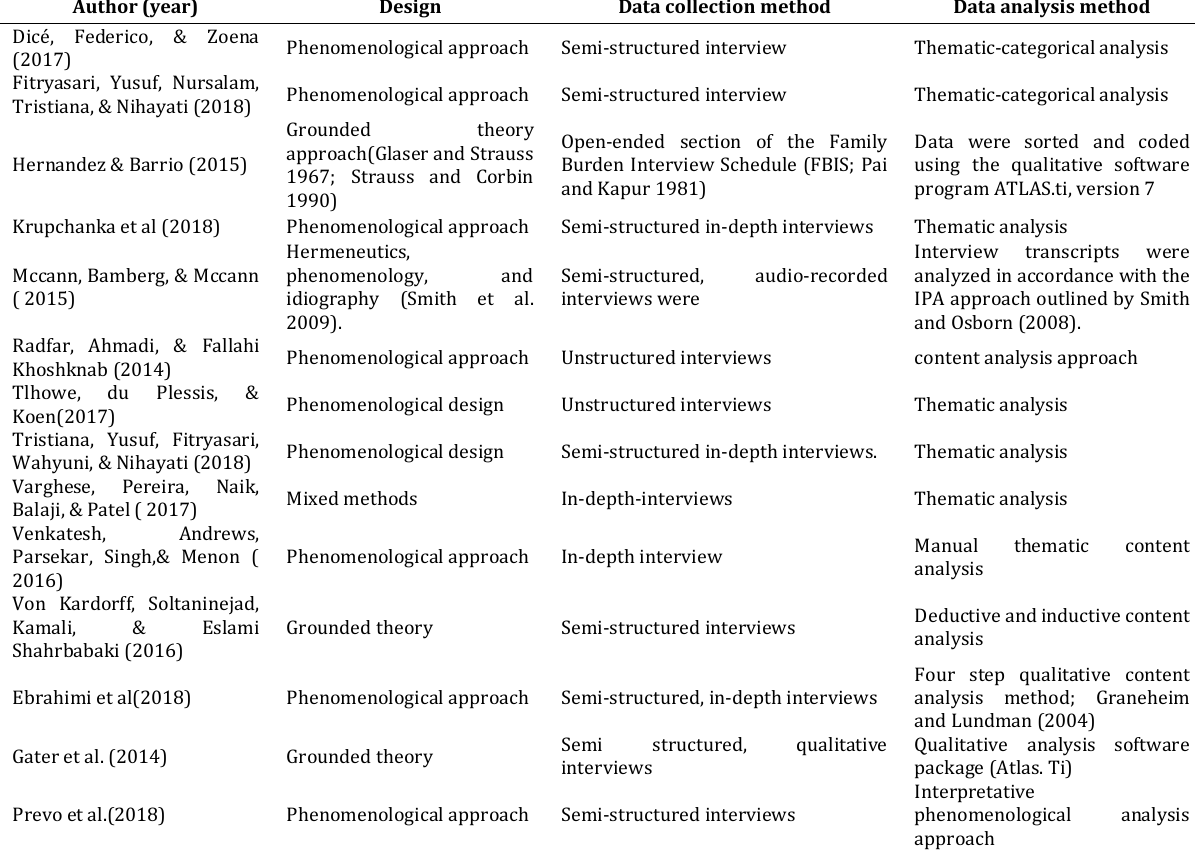
Table 3. Study characteristics (design, data collection method & data analysis method) Author